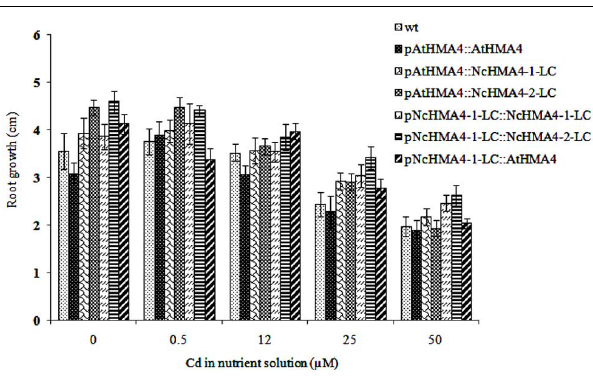
FIGURE 10 | Effect of Cd on root growth in Arabidopsis wt and transgenic lines . Root length increments were measured after 4